Question: What form of chart is displayed?
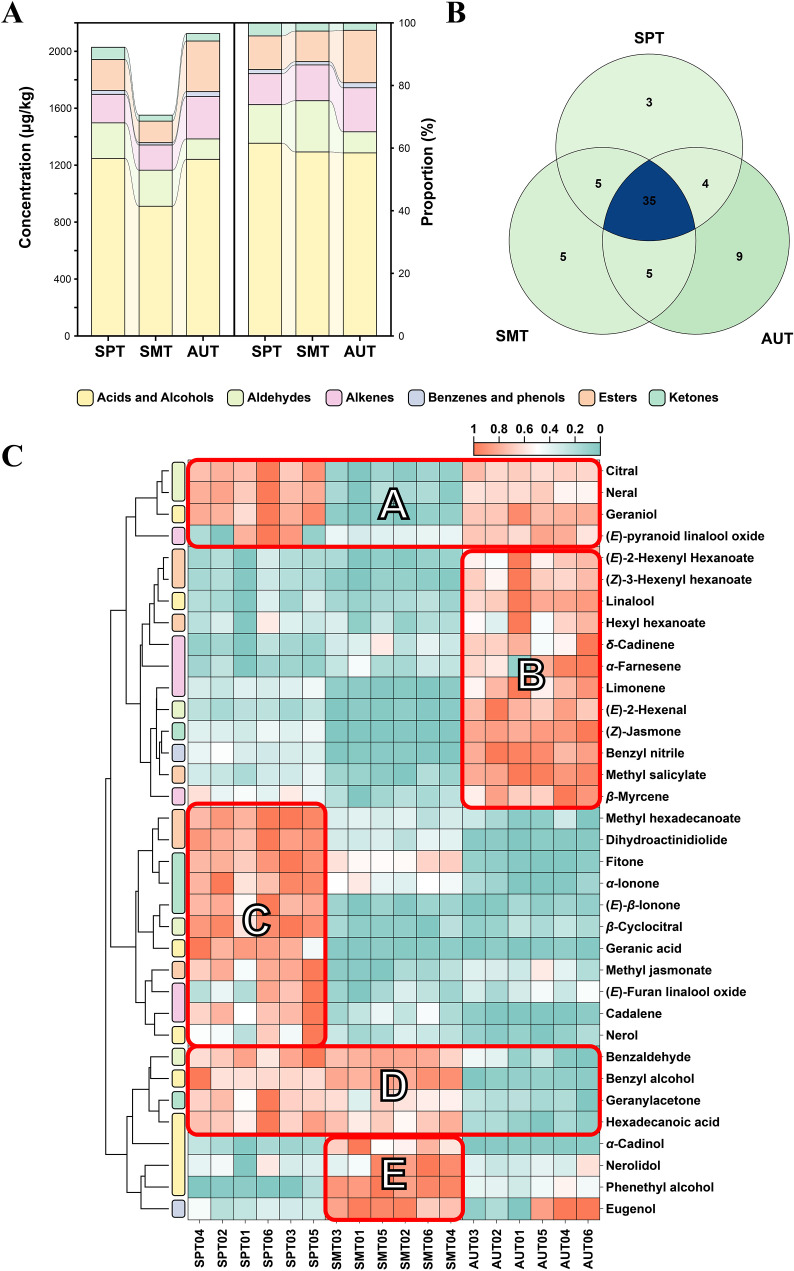
Answer: heatmap